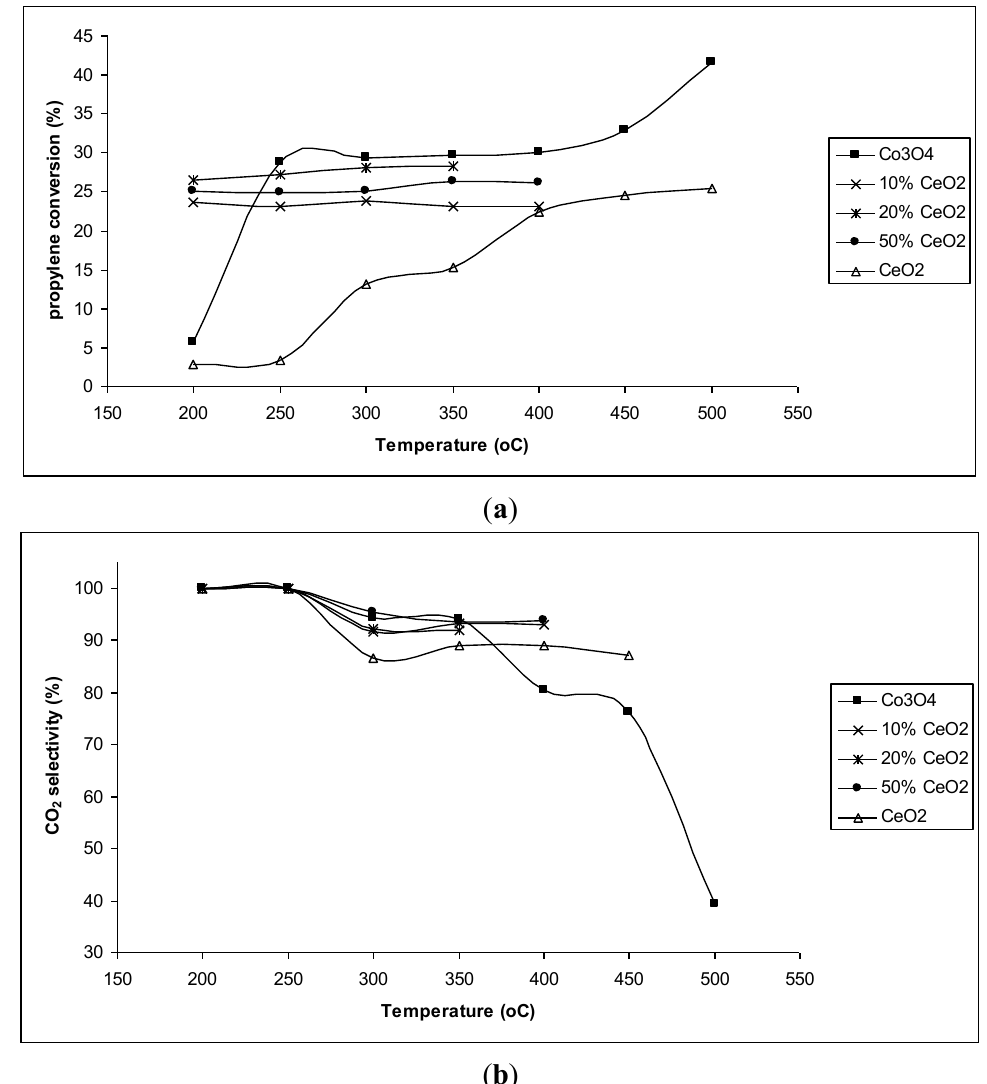
Figure 6. ( a ) Propylene conversion (%) and ( b ) CO 2 selectivity (%) of CeO 2 –Co 3 O 4 chemical mixtures at different reaction